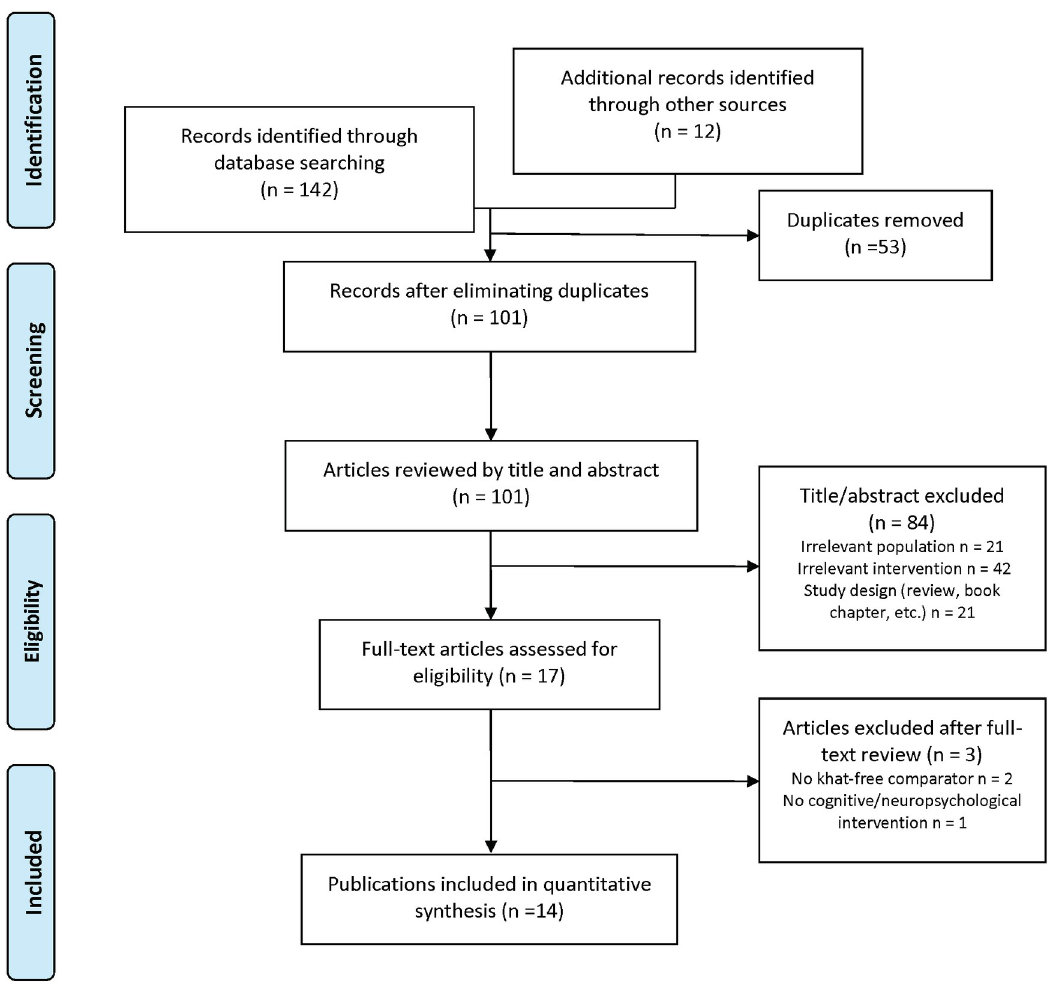
Fig 1. Flow chart of articles included and excluded after the systematic